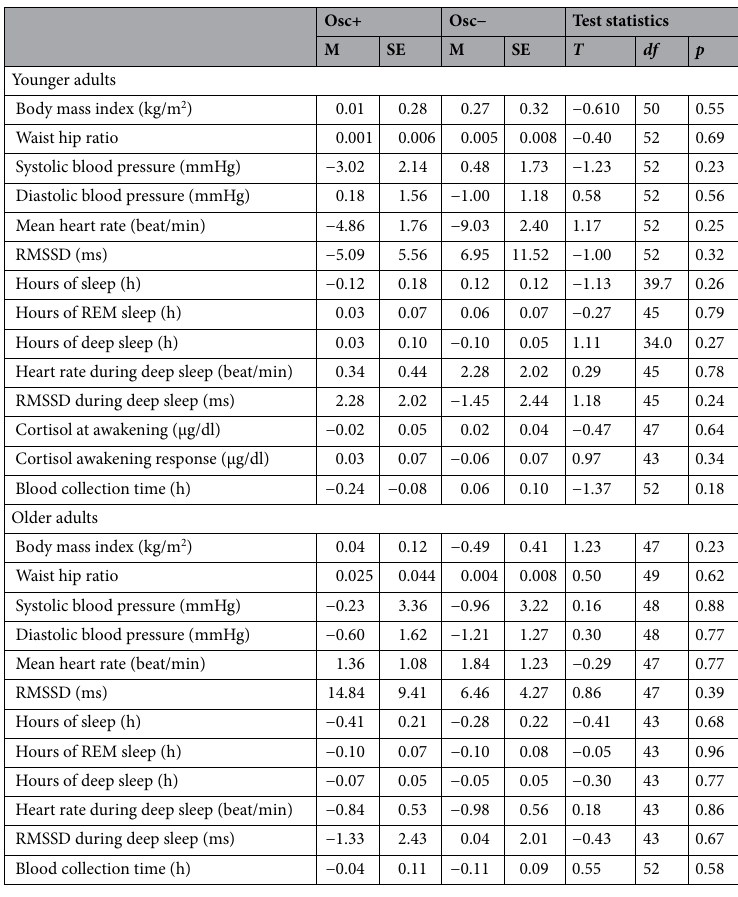
Table 3. Comparison of pre- and post-intervention changes (post–pre) between Osc+ and